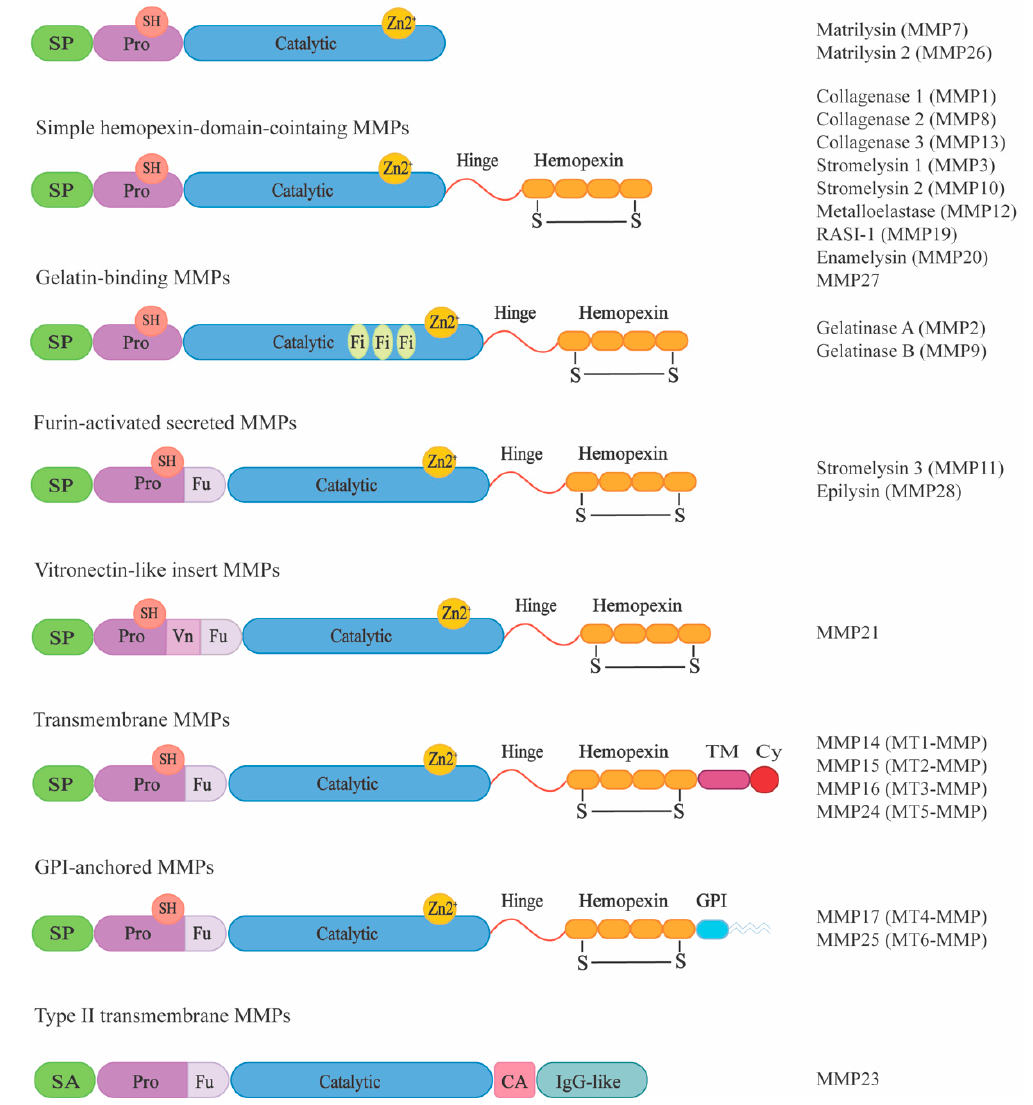
Figure 1. MMP multidomain organization. Based on their domain structure, MMPs can be subdivided into eight different groups. All MMPs share a common structure comprising a signal peptide (SP), a pro-domain (Pro), containing a thiol group (SH), a catalytic domain (Catalytic) with a zinc (Zn) binding site, a linker region (Hinge) and a hemopexin domain (Hemopexin), which has a disulfide bond (S-S). Exceptions to this are the two gelatinases, which contain three fibronectin repeats (Fi) within their catalytic domain and furin-activated MMPs which have a furin-recognition site (Fu) within their pro-domain and MMP21 with an additional vitronectin-like insert (Vn). Some membrane-type MMPs are anchored to the membrane via glycosylphosphatidylinositol (GPI), whereas some MT-MMPs have transmembrane (TM) and cytosolic domains (Cy). In type II MT-MMPs, an N-terminal signal anchor (SA), a cysteine array (CA) domain, and an immunoglobulin-like (Ig-like) domain are present. Adapted by permission from “Springer Nature: New functions for the matrix metalloproteinases in cancer progression. Nat. Rev. Cancer 2002 , 2 , 161–174. Egeblad & Werb, Copyright (2002)”.